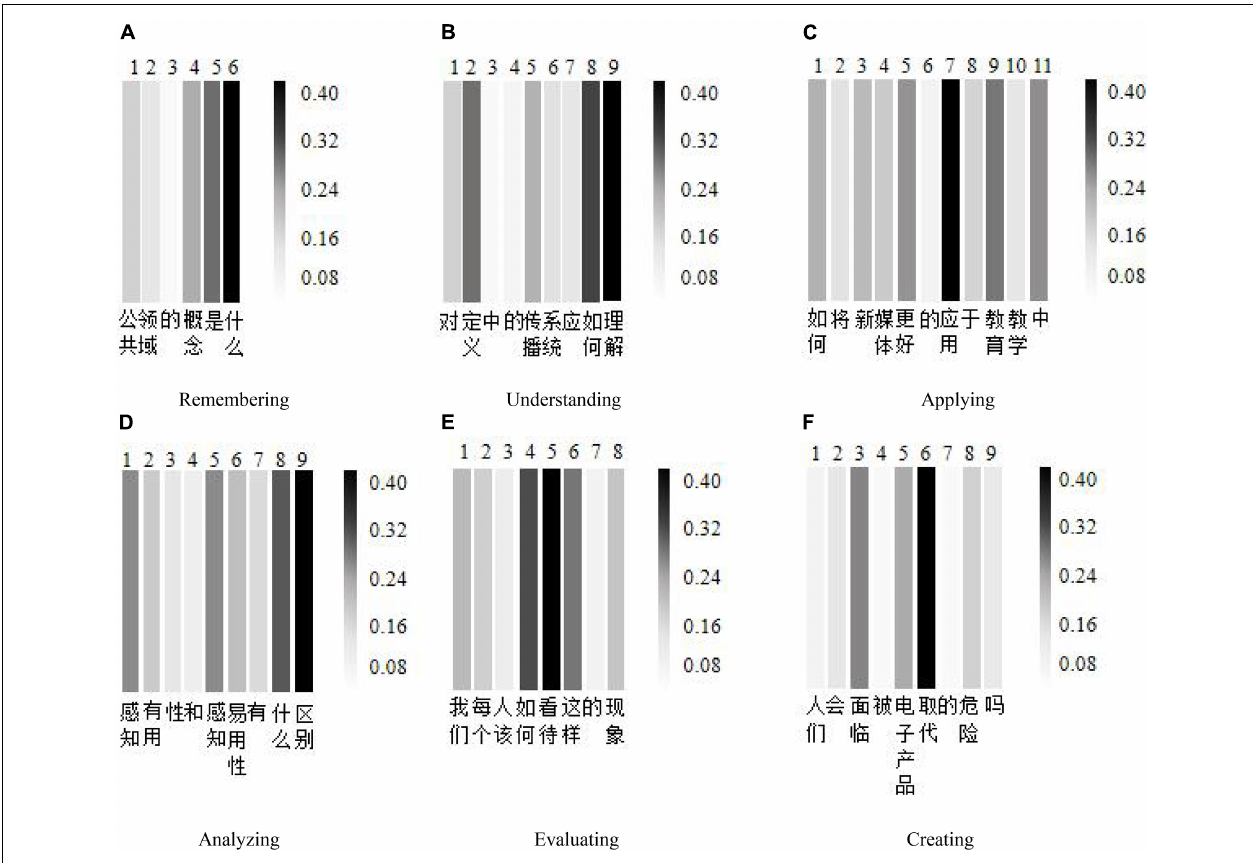
FIGURE 9 | Heat map of attention mechanism weight. (A) Remembering. (B) Understanding. (C) Applying. (D) Analyzing. (E) Evaluating. (F)